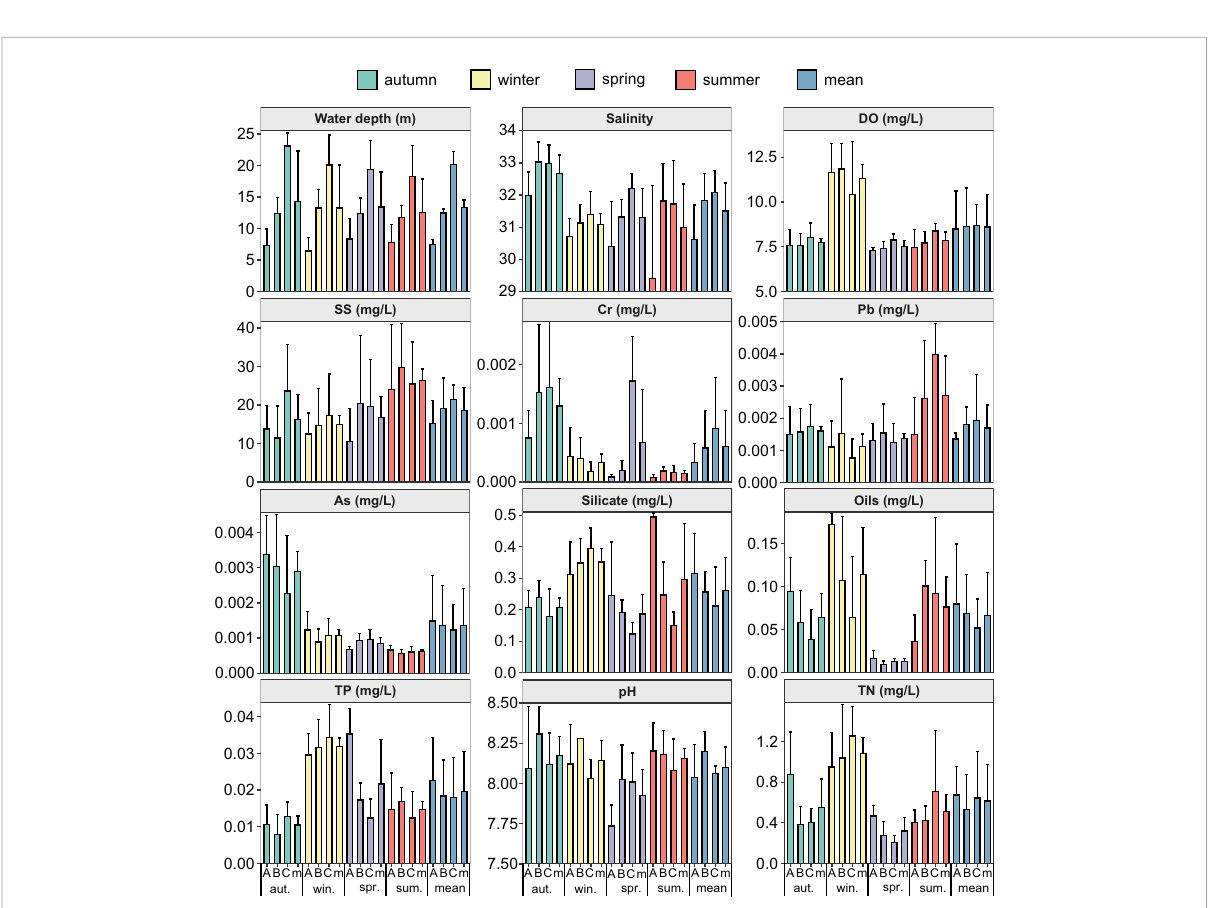
FIGURE 4 The spatial and temporal distributions of twelve environment factors in subtidal zone near the Daya Bay Nuclear Power Plant. (A: represent the inner bay; B: represent the middle bay; C: represent the outside bay; m: represent the mean value).